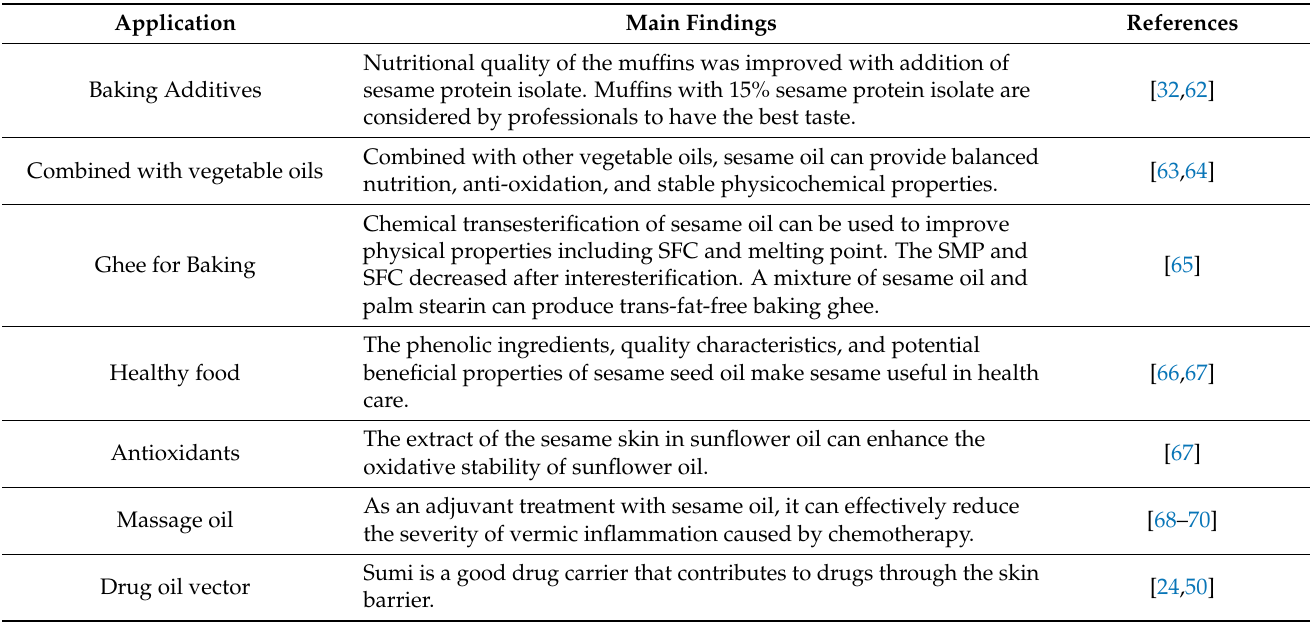
Table 3. Applications of sesame in various